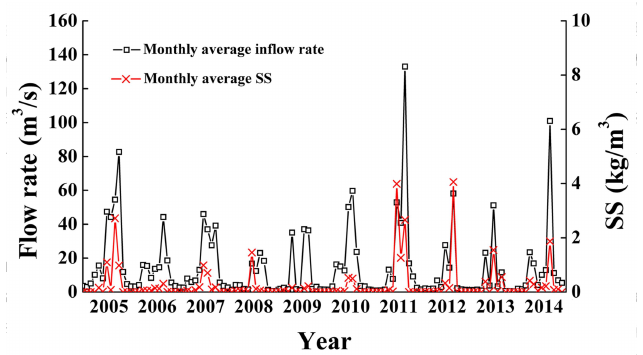
Figure 2. Variation in monthly average flow rate and suspended sediment (SS)